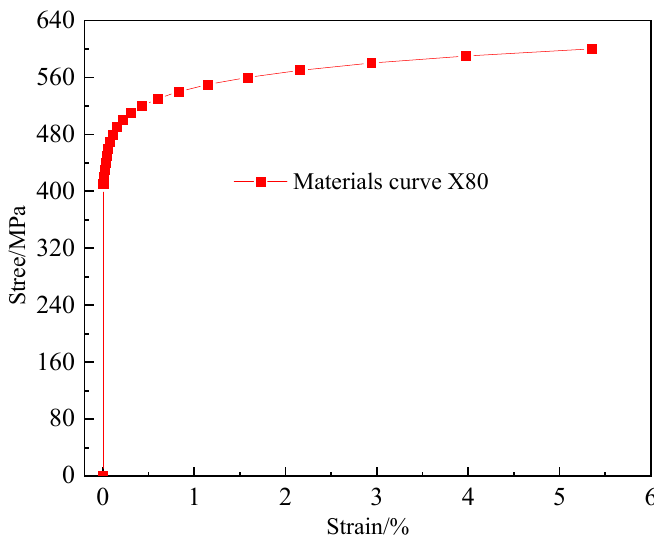
Figure 2. True stress–strain curve of the X80 steel.